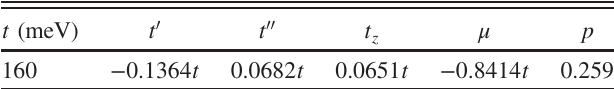
TABLE I. Tight-binding parameters from the ADMR data of Nd-LSCO p ¼ 0 . 24 obtained from the angle-dependent mag- netoresistance analysis in Ref. [17]. The hopping parameter t ¼ 160 meV is adjusted to meet the specific heat data on the same sample; more details can be found in the Methods section in Ref. [17].